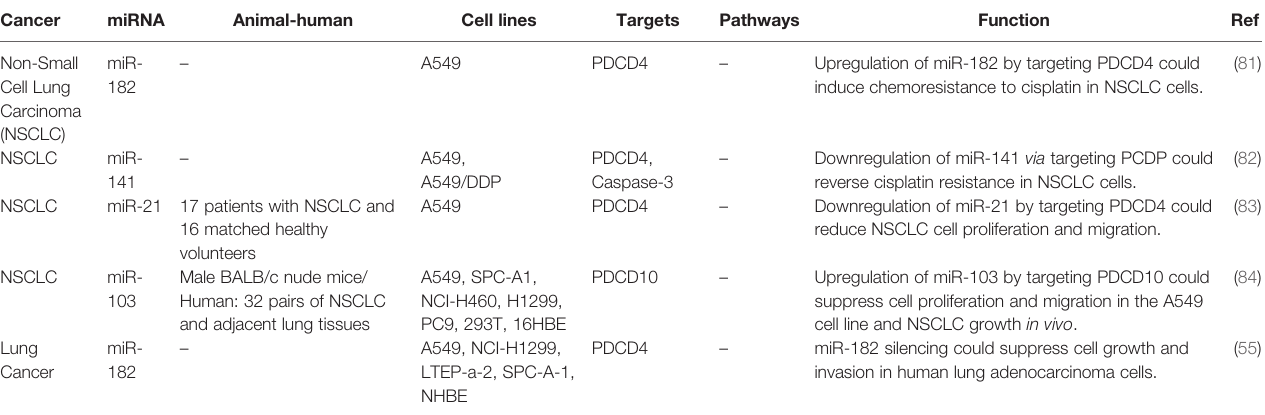
TABLE 7 | Interaction between miRNAs and PDCD in lung cancer.